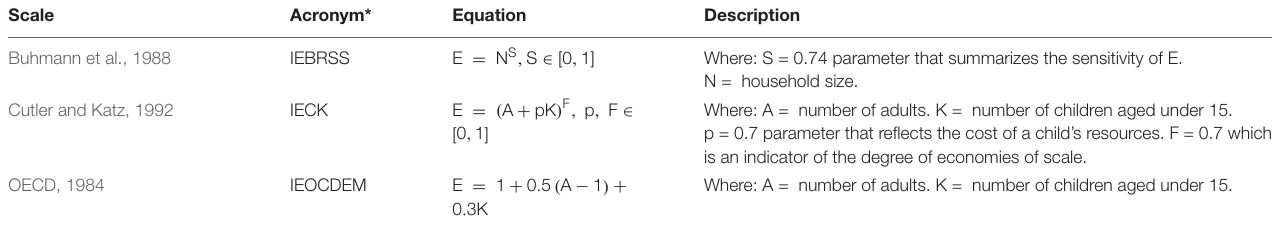
TABLE 2 | Equivalence scales for estimating monetary poverty.